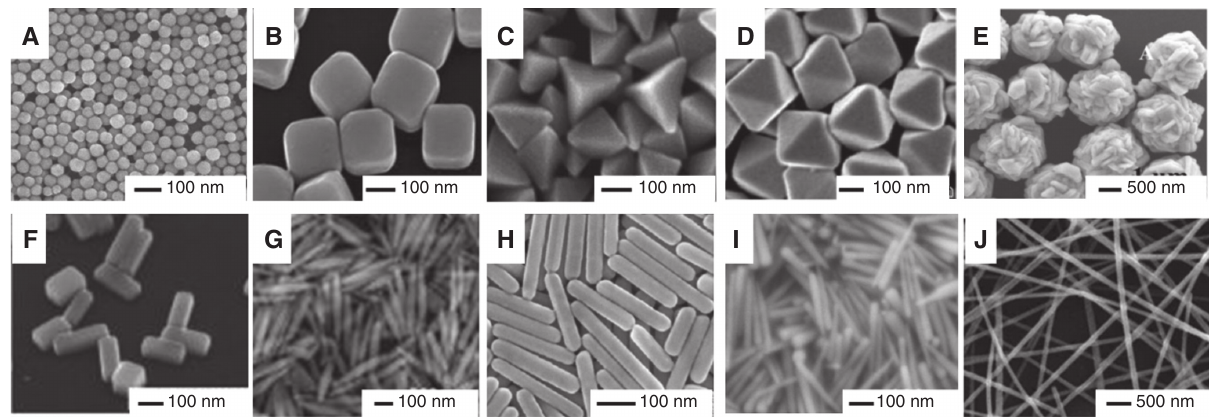
Figure 1: Different shapes of silver nanostructures. (A) spheres [17], (B) cubes [18], (C) right bipyramids [19], (D) octahedrons [20], (E) flowers [21], (F) bars [22], (G) rices [23], (H) rods [24], (I) carrots [25], and (J) wires [26]. Reproduced with permission from Refs. [17–26].